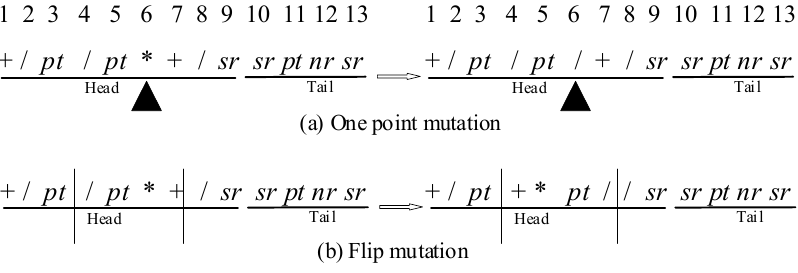
Figure 5. Mutation (black triangle express location of one point mutation).